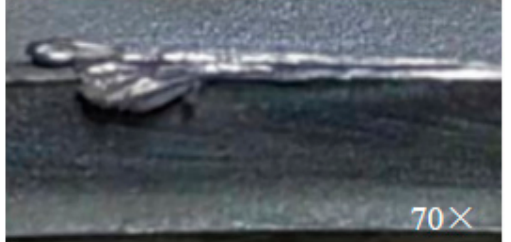
Figure 7. Wear of labyrinth seal fin under high incursion rate.